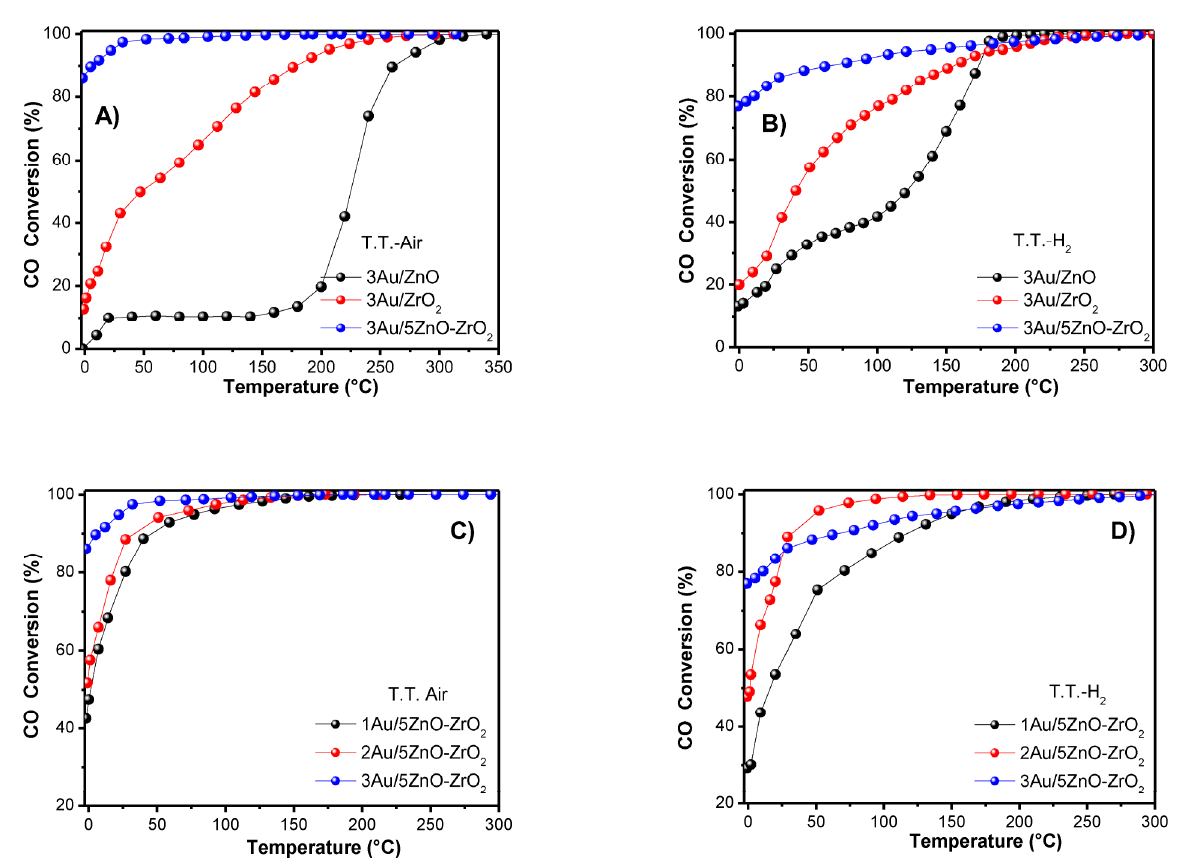
Figure 7. Temperature profiles and performance displayed by the tested catalysts: ( A , B ) comparison of CO conversions as functions of the reaction temperature for the 3Au/ZrO 2 , 3Au/ZnO , and 3Au/5ZnO − ZrO 2 catalysts, GHSV of 46,000 h − 1, treated under air or H 2 atmosphere at 200 °C; com- parison of CO conversions for the 1Au/5ZnO − ZrO 2, 2Au/5ZnO − ZrO 2 , and 3Au/5ZnO − ZrO 2 catalysts with different gold loadings (1, 2, and 3 wt. %) using thermal treatments under air ( C ) or hydrogen ( D ) atmosphere at 200 °C and GHSV of 46,000 h − 1 . Table 3. Reaction temperature comparison to achieve 10, 50, or 90% of CO conversion of the differ- ent catalysts activated at 200 °C under air and H 2 thermal treatments.